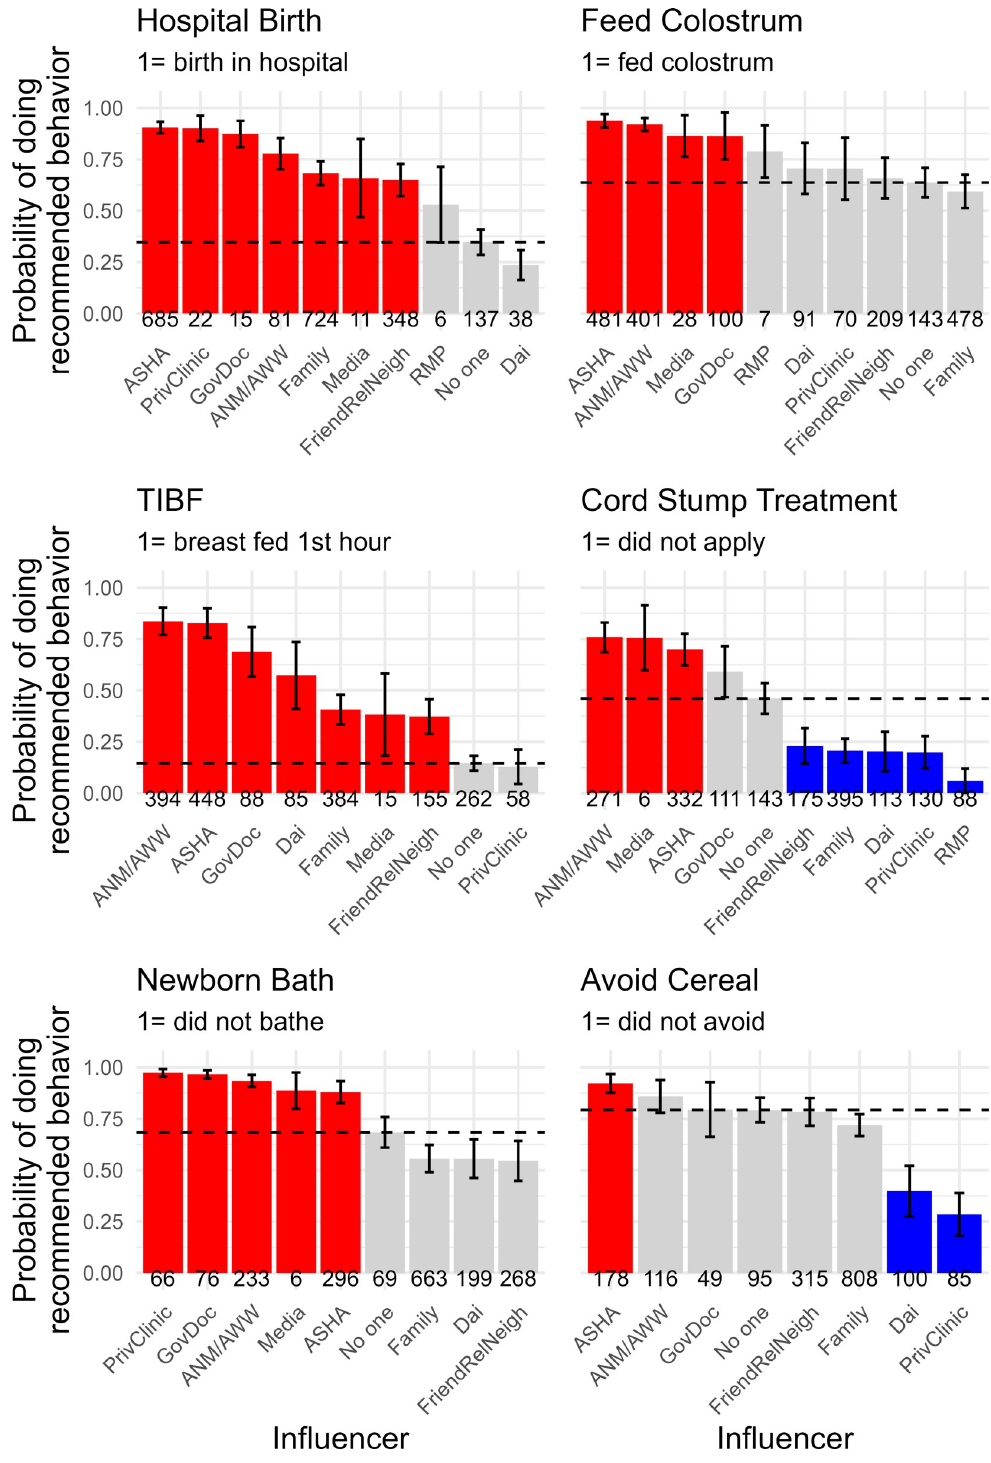
Fig 6. Model predicted probabilities of doing each recommended behavior postpartum. Red bars are positive effects (confidence intervals that are above and do not overlap with the reference category of no one). Grey bars are effects similar to no one (confidence intervals overlap). Blue bars are negative effects, meaning the influencer lowers the probability that the woman practices the recommended behavior compared to the reference category of no one. The thin black dashed line is drawn at the predicted probability of the reference category, ‘no